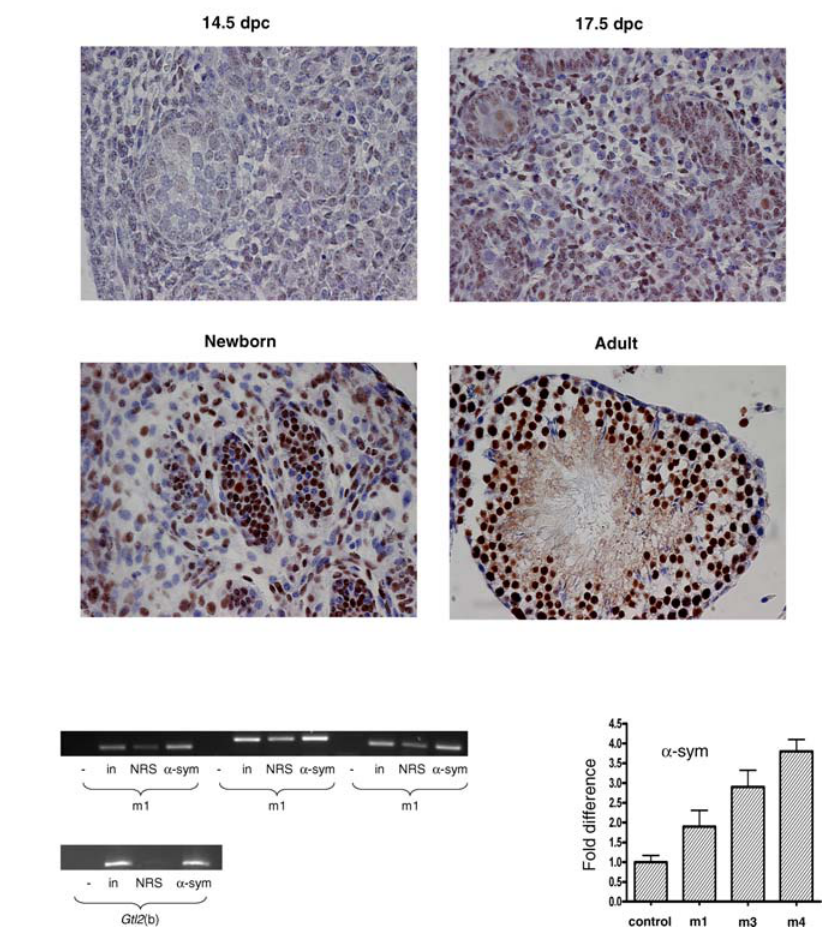
Figure 7. Developmental Accumulation of SYM-R3H4 in Mouse Testis (A) Significant SYM-R3H4 is first observed in the nuclei of cells composing the testis at 17.5 dpc. Subsequent stages, newborn and adult, exhibit strong nuclear staining of the majority of cells within the testis. (B) ChIP analysis of SYM-R3H4 in adult testis. The right panel shows the quantitative PCR analysis of the m1, m3, and m4 regions whereas the left panel shows an ethidium bromide–stained gel of the PCR products. Also shown are the PCR products of the ChIP analysis of the b region of Gtl2 DMR. DOI: